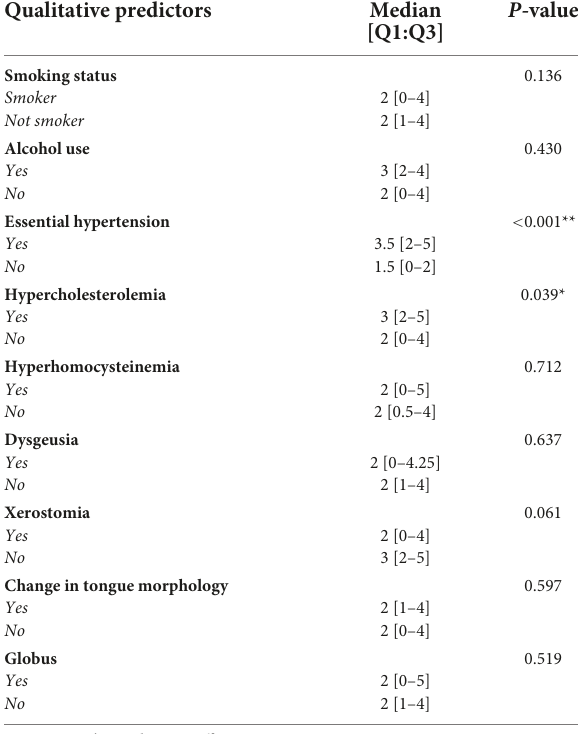
r isSpearman’scorrelationcoefficient.